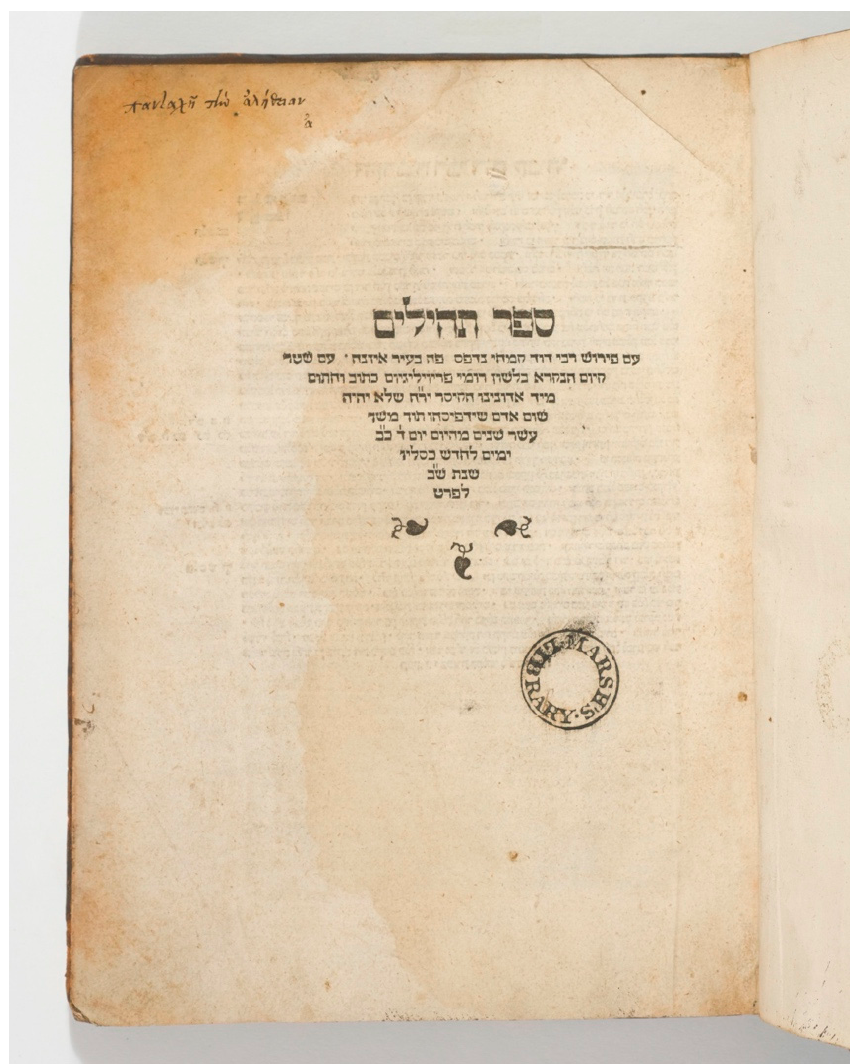
Figure 3. Sefer Tehilim with commentary from David Kim ḥ i; Marsh’s Library B.3.3.1.